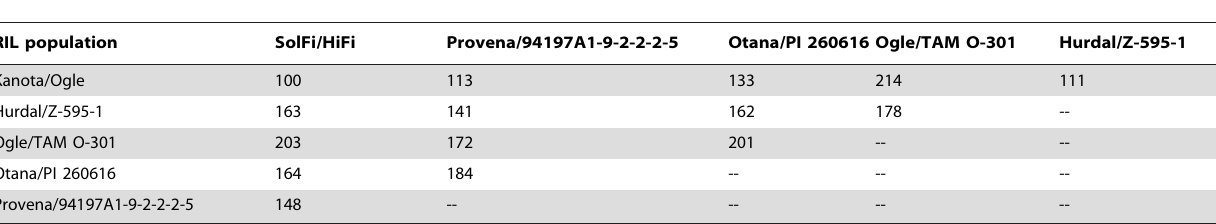
Table 3. Pairwise comparison of common SNP markers across hexaploid oat populations.